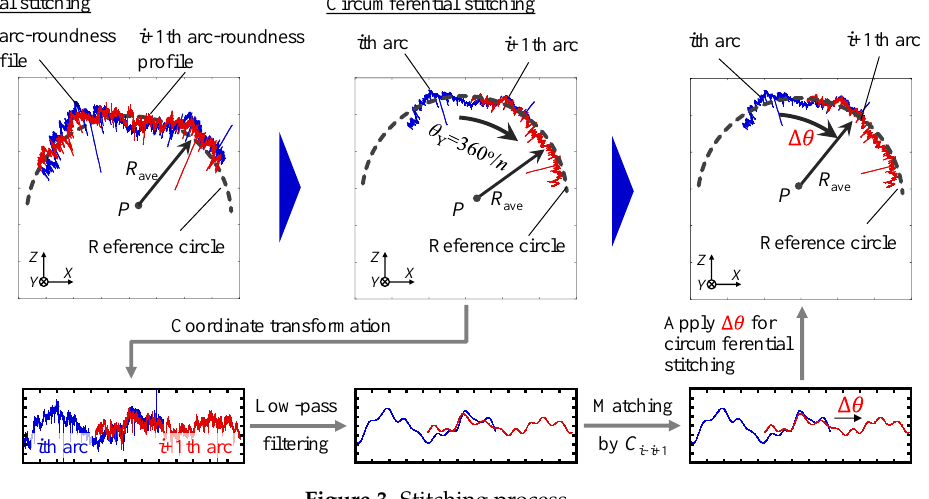
Figure 3. Stitching process.